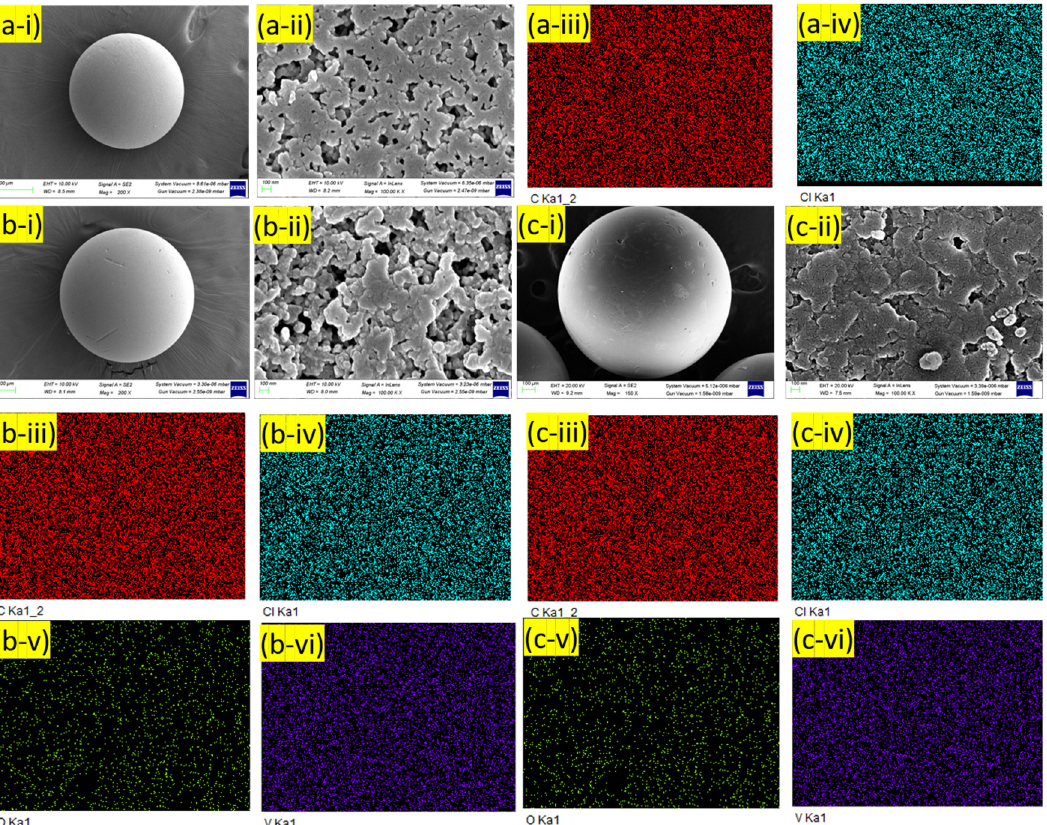
Figure 4. FE-SEM image ( a-i ), high-resolution FE-SEM image ( a-ii ), and elemental mapping of C ( a-iii ), and Cl ( a-iv ) of chloromethylated polystyrene (PS-Cl). FE-SEM image ( b-i ), high-resolution FE-SEM image ( b-ii ), elemental mapping of C ( b-iii ), Cl ( b-iv ), O ( b-v ) and V ( b-vi ) of [V V O 2 (sal- aebmz)]@PS. FE-SEM image ( c-i ), high-resolution FE-SEM image ( c-ii ), and elemental mapping of C ( c-iii ), Cl ( c-iv ), O ( c-v ), and V ( c-vi ) of [V V O 2 (sal-aebmz)]@PS after the first cycle.